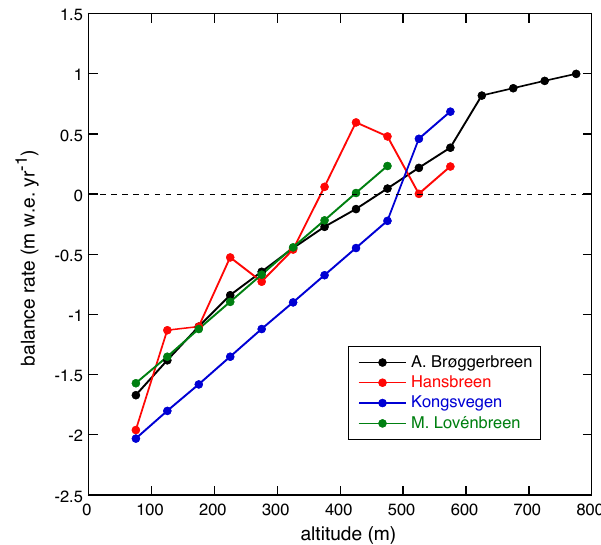
Figure 5. Observed mean balance profiles for Austre Brøggerbreen (1990–2009), Hansbreen (1991–2009), Kongsvegen (2000–2009) Fig. 5 . Observed mean balance profiles for Austre Brøggerbreen (1990-2009), Hansbreen 3 and Midtre Lovénbreen (2000–2009). Data are from the World (1991-2009), Kongsvegen (2000-2009) and Midtre Løvenbreen (2000-2009). Data from the 4 Glacier Monitoring Service World Glacier Monitoring Service (Zürich). 5